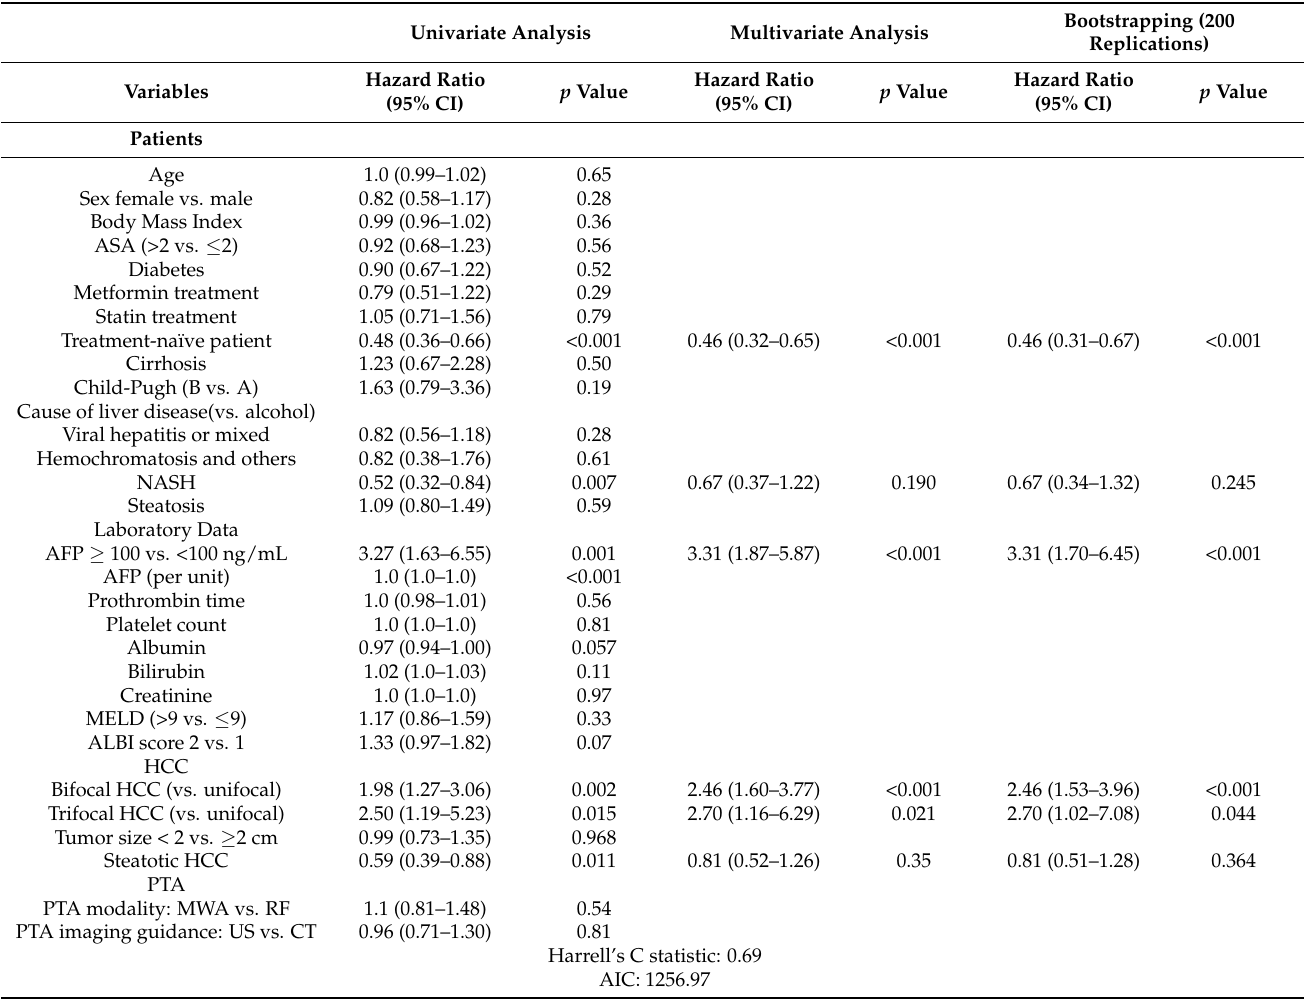
Table 4. Univariate and multivariate Cox regression models to predict RFS (per patient.analysis).